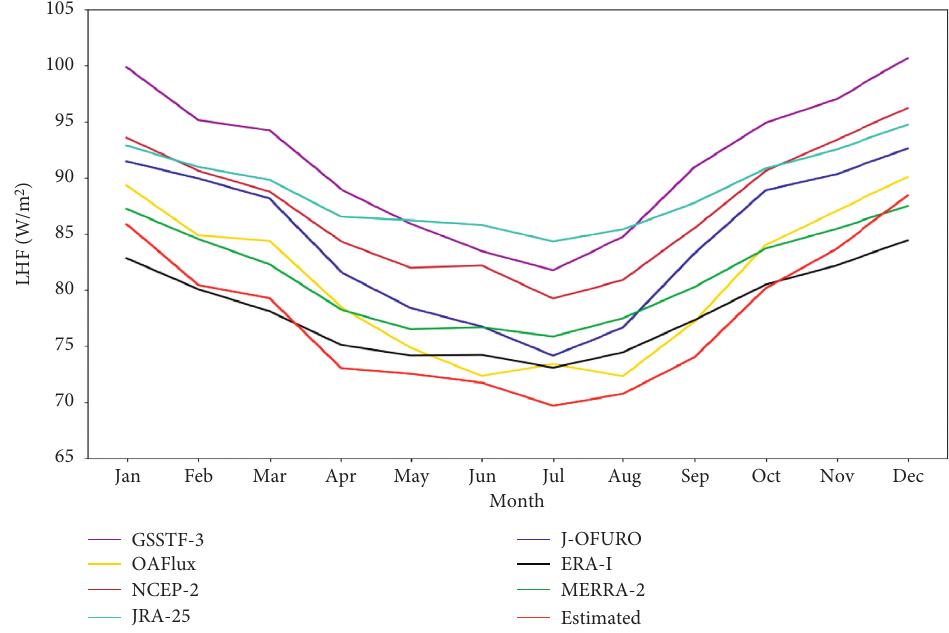
Figure 9: Seasonal variability of oceanic average latent heat flux derived from eight LHF